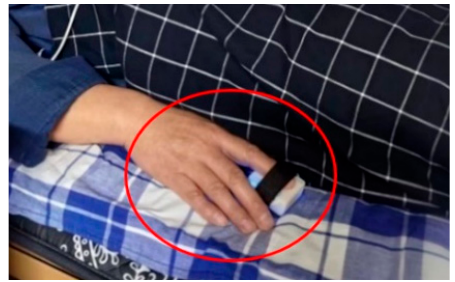
Figure 3. PPG signal collection experiment.